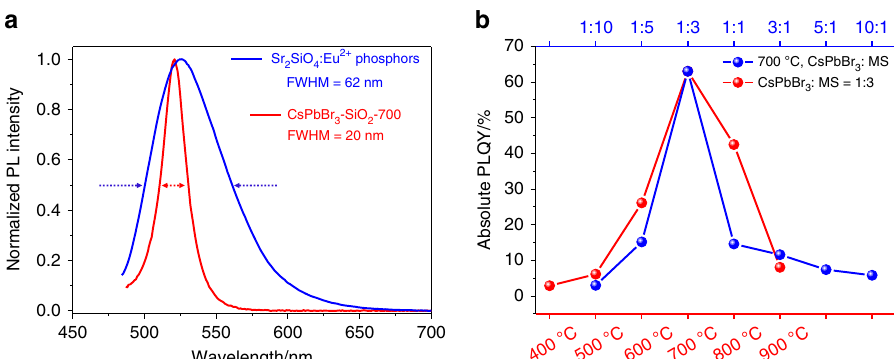
Fig. 3 Optical properties of CsPbBr 3 – SiO 2 . a Photoluminescence emission spectra of CsPbBr 3 – SiO 2 – 700 and ceramic Sr 2 SiO 4 : Eu 2 + green phosphor, excitation wavelength is 455 nm. b Absolute PLQYs of CsPbBr 3 -SiO 2 (mass ratio of CsPbBr 3 : MS is 1:3, red mark) synthesized at different temperatures, absolute PLQYs of CsPbBr 3 -SiO 2 synthesized at 700 °C with different mass ratios of CsPbBr 3 : MS (blue